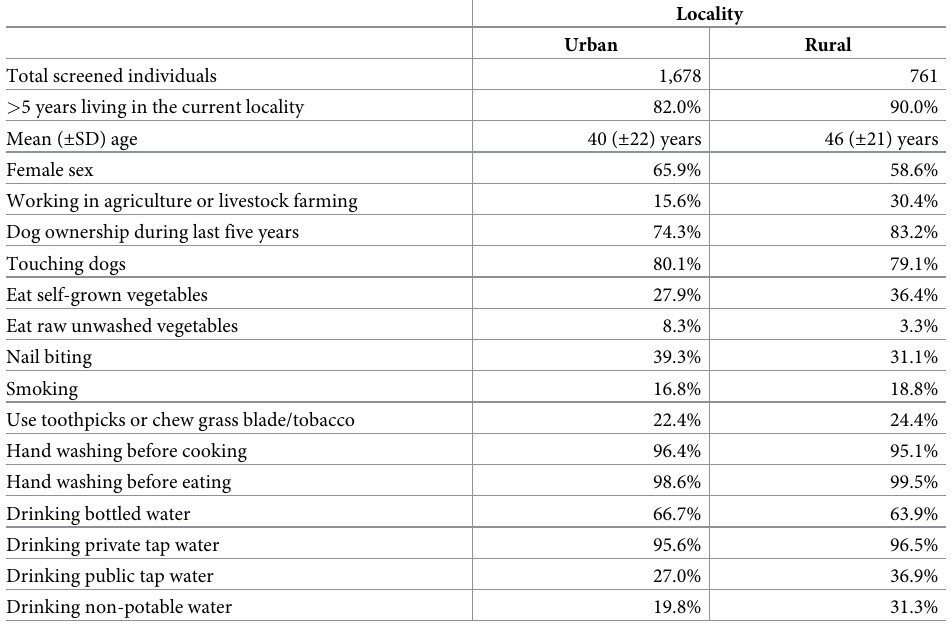
Table 1. Demographic and investigated behavioral features that could be risk factors for abdominal cystic echino- coccosis in localities of the Monte Patria municipality, Chile.